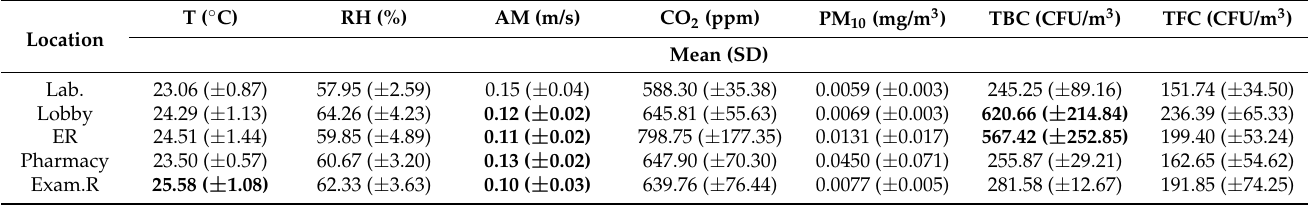
Table 2. Indoor air quality parameters at different sites of the health clinics.